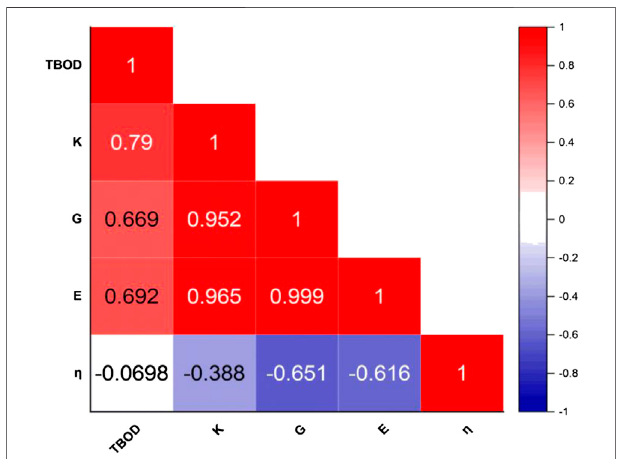
FIGURE6| Correlationmatricesforthemechanicalpropertieswitheach other and TBOD.